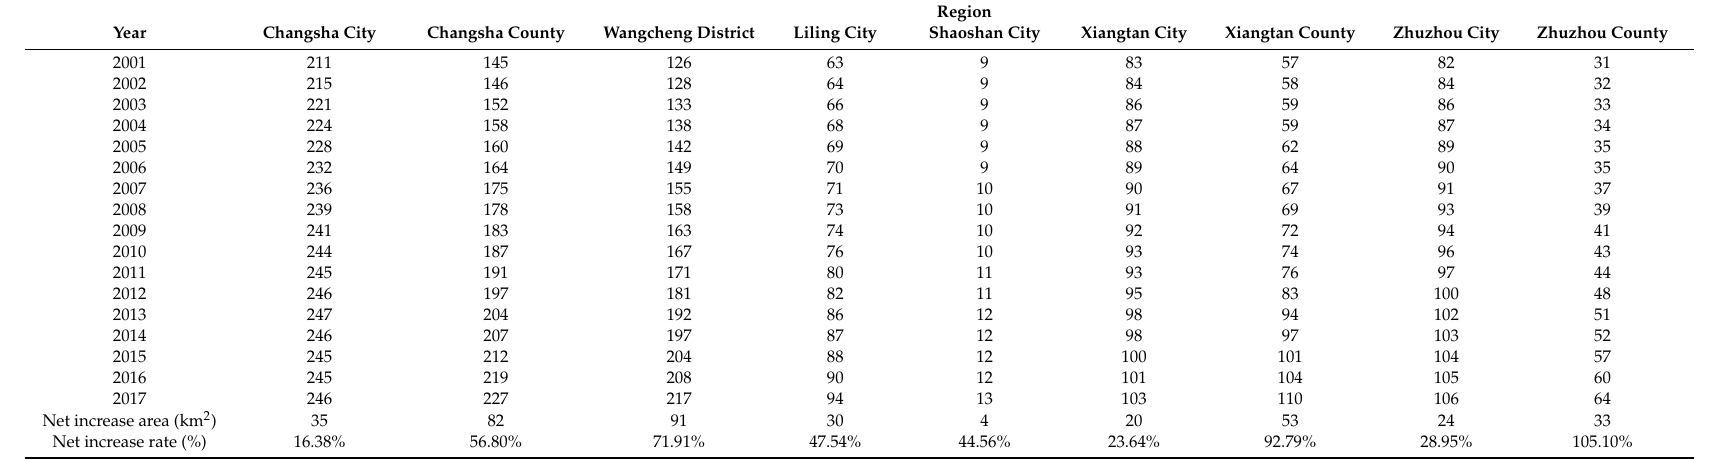
Table A4. Annual impervious surface area (km 2 ), Net increase area (2001–2017) (km 2 ) and Net increase rate (2001–2017) (%) in di ff erent regions of